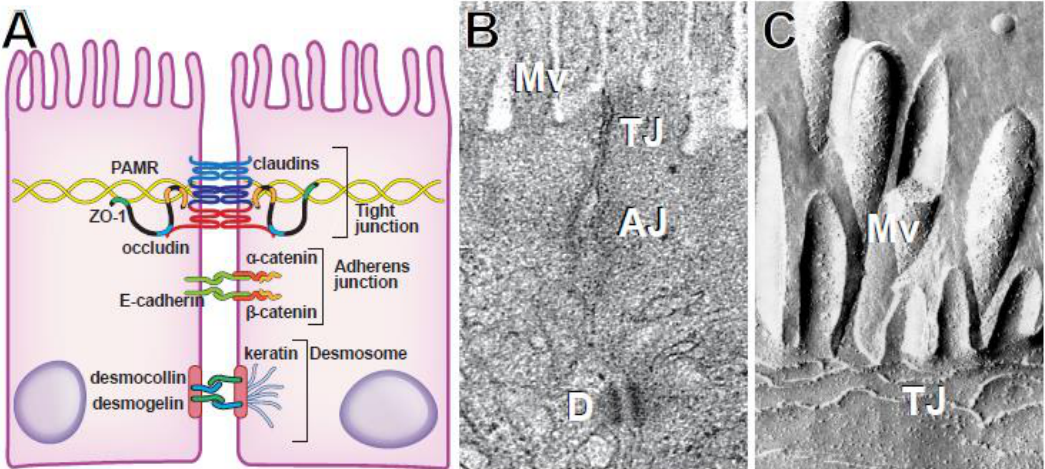
Figure 1. The structure of epithelial intercellular junctions. ( A ) Schematic showing interactions between the perijunctional actomyosin ring (PAMR), zonula occludens-1 (ZO-1), occludin, claudins at the tight junction; E-cadherin, α -catenin, and β -catenin at the adherens junction; and desmogelin, desmocollin, and intermediate filaments at the desmosome. ( B ) Transmission electron micrograph showing the tight junction (TJ), adherens junction (AJ), desmosome (D), and microvilli (Mv). From Turner. Nat Rev Immunol 2009. ( C ) Freeze-fracture electron micrograph of intramembranous tight junction strands. From Shen et al. Annu. Rev. Physiol. 2011.